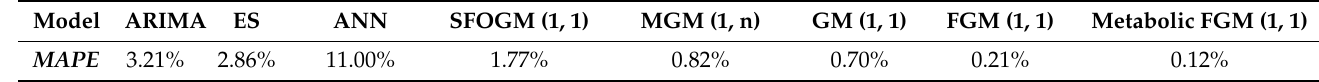
Table 4. Comparison with similar studies in the literature. Model